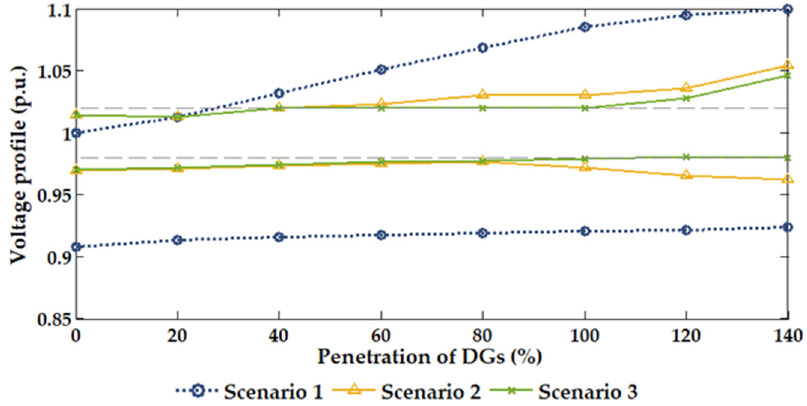
Figure 10. Voltage ranges with different DG penetrations.